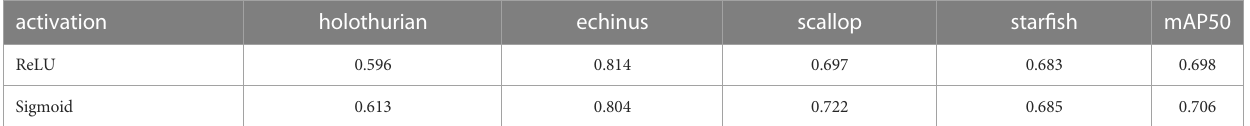
TABLE 4 Performance of different activation functions on the S-UODAC